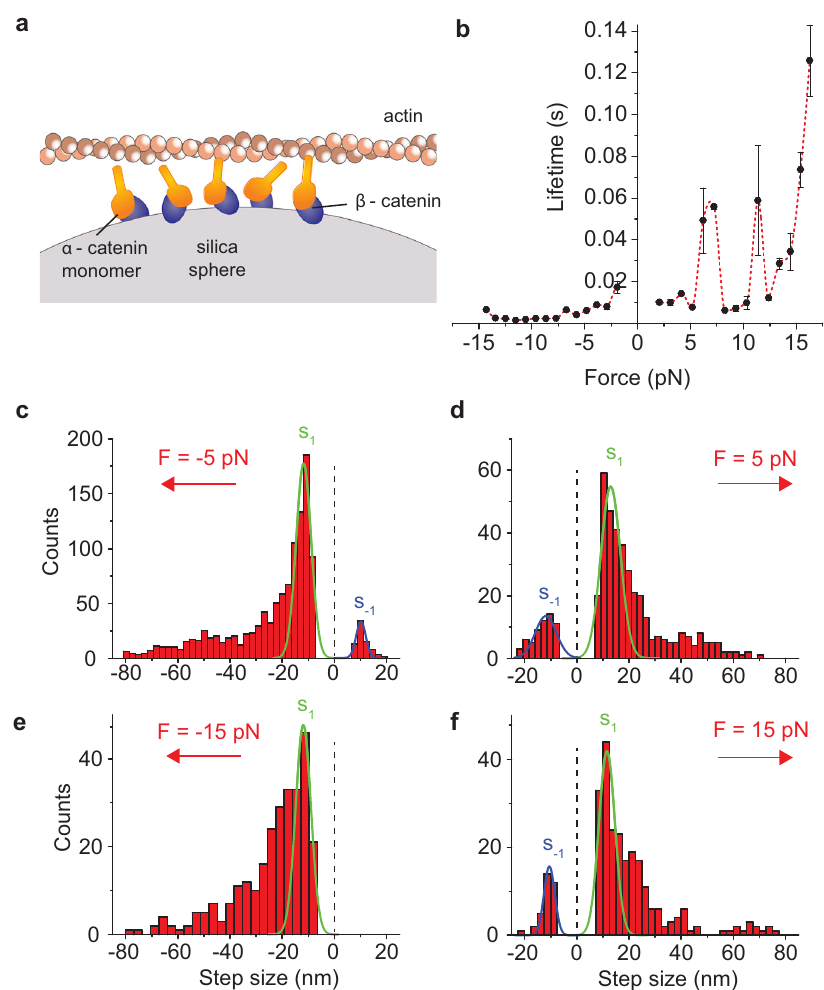
Fig. 3 Multiple α - β -catenin heterodimers restore force-bearing capability on F-actin. a Schematic of ultrafast force-clamp spectroscopy applied to multiple α - β -catenin heterodimers. Multiple heterodimers are composed by monomeric His(6x) tagged α -catenins attached onto a layer of GST-tagged β - catenin (see methods). b Load-dependent lifetime of the interaction between multiple α - β -catenin heterodimers and F-actin. n = 55171 total number of interactions for all points in the plot. Error bars, s.e.m. c – f Distribution of step size at various forces. Gaussian fi ts (green and blue lines) of the main peaks are also shown with their center and s.d. c F = − 5 pN. s 1 = − 11.7 ± 2.9 nm, s -1 = 10.2 ± 1.8 nm. d F = + 5 pN, s 1 = 12.8 ± 3.8 nm, s -1 = − 12.1 ± 4.0 nm. e F =